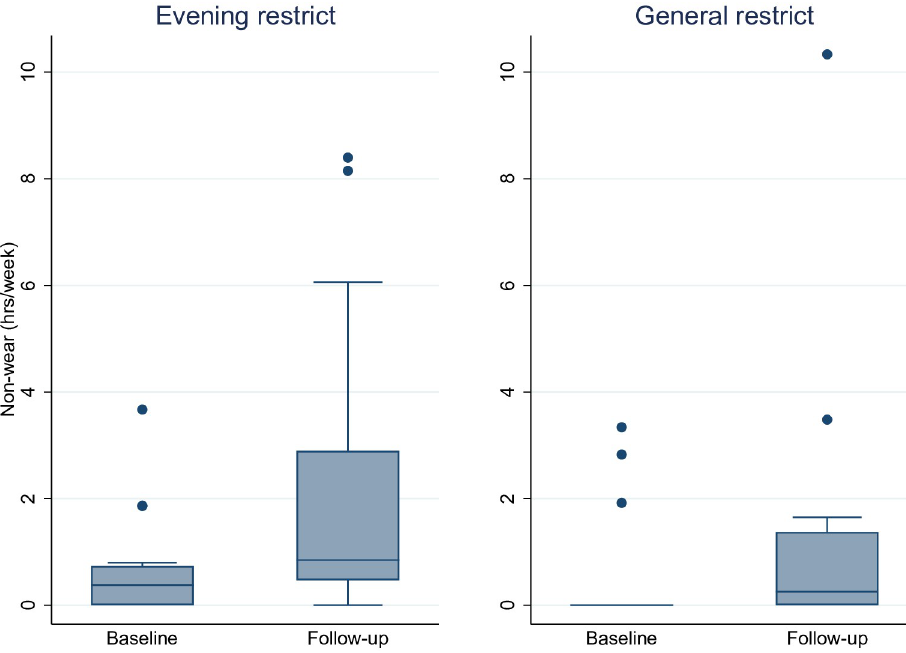
Fig 3. Graphical overview of compliance to accelerometry during leisure (excluding sleep) at baseline and follow- up. The figure above illustrates the total number of hours of non-wear at baseline and follow-up, for each intervention group. Baseline and follow-up were each seven days in duration and spanned eight days (the same weekdays twice). Non-wear for adults and children is shown together, above. Hours of non-wear is restricted to only leisure time and during awake hours based on reporting in daily schedules, at both baseline and